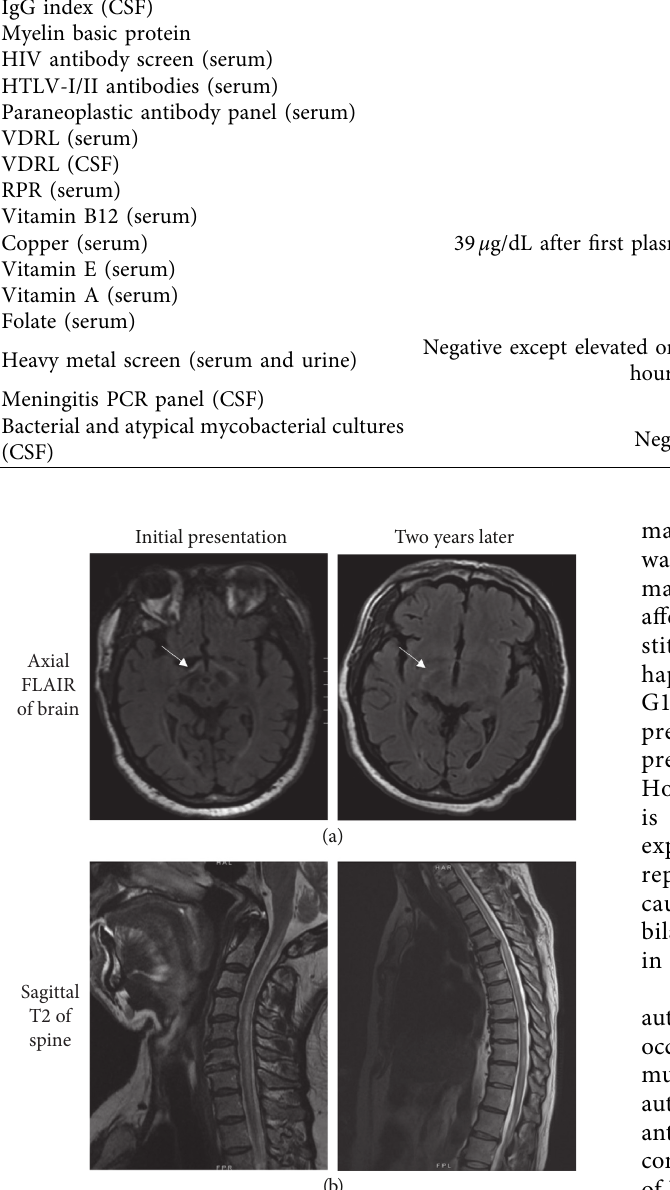
Figure 1: (a) MRI of the orbits showed T2 hyperintensities on FLAIR sequences to the bilateral optic nerves and optic tracts at each presentation (arrows). (b) Spinal MRIs showed longitudinally extensive nonenhancing T2 hyperintensities in distinctly different locations at each